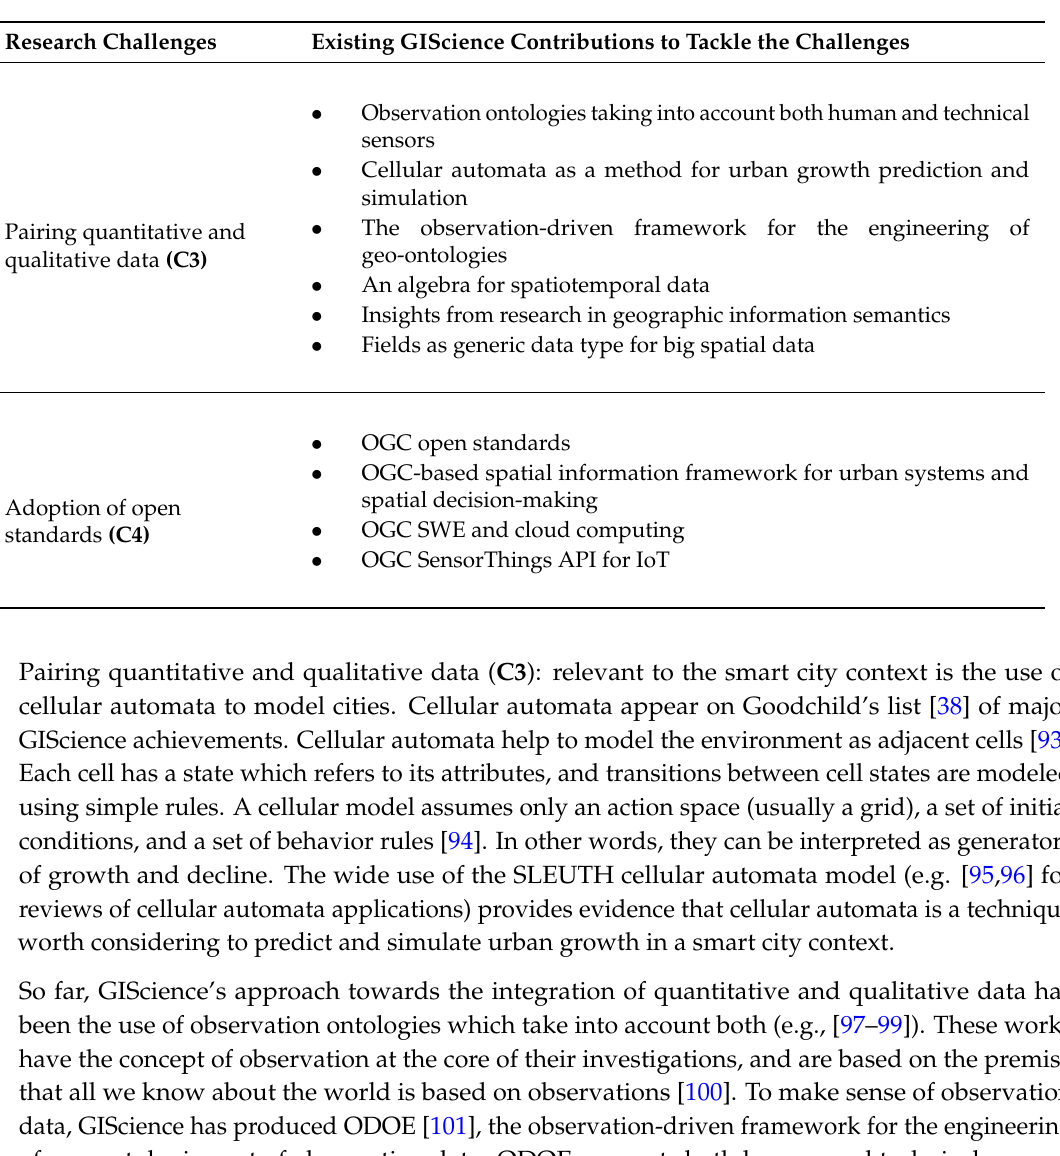
Table 2. Matching GIScience contributions to citizen-centric smart city challenges (Theme: analytical methods and tools). The suite of Open Geospatial Consortium (OGC) open standards is a good starting point for the exchange of (geospatial) information in a smart city